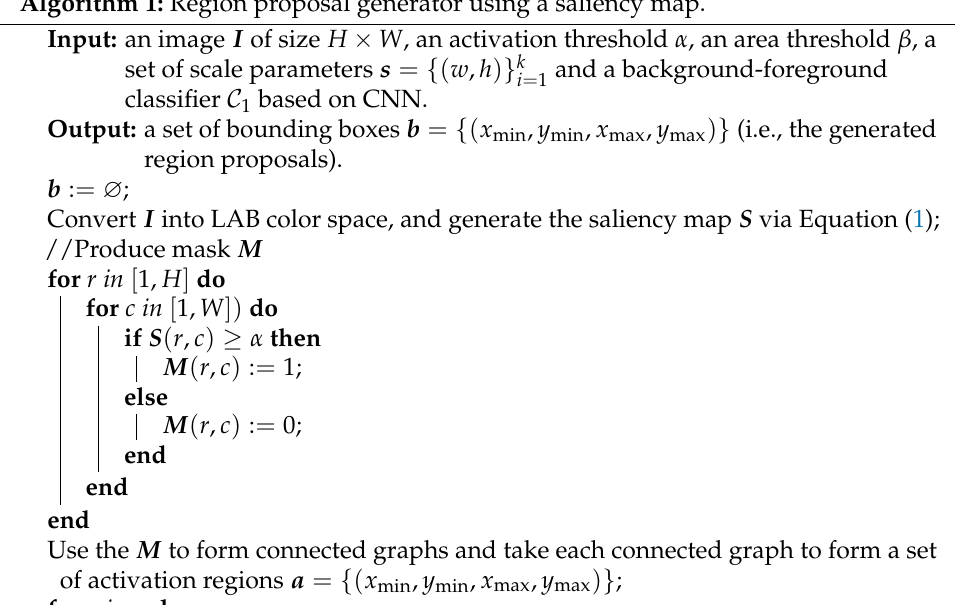
Algorithm 1: Region proposal generator using a saliency map.